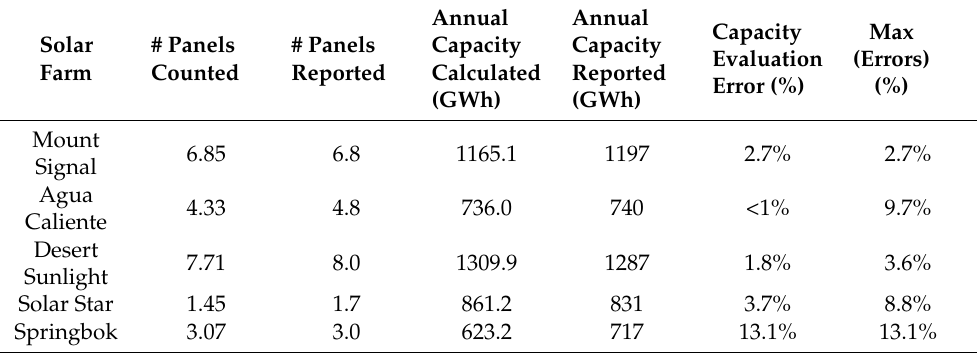
Table 5. Capacity calculation results. We report the average of the two error values for each solar farm, which lies in the range